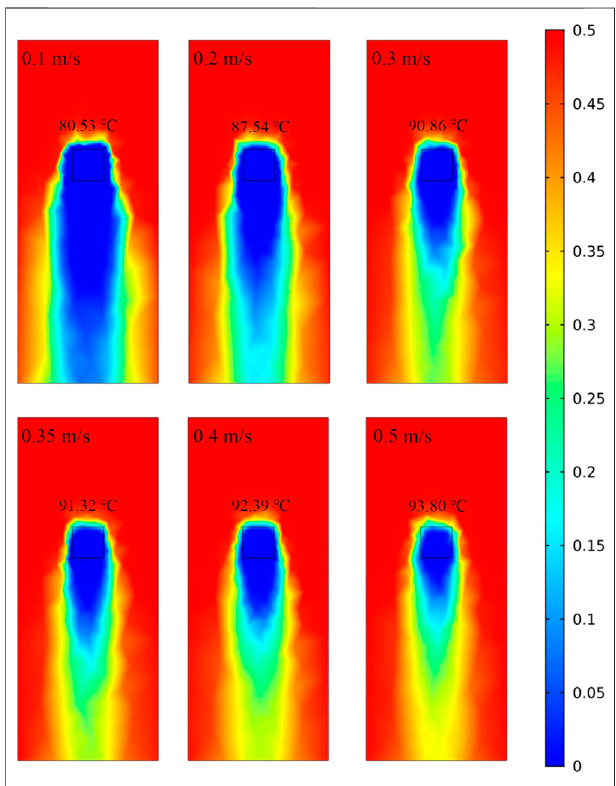
FIGURE12| Theeffectofthechangeinthesteam fl owrateonthephase change fi eld (the steam fl ow rate and the condensation surface temperature are given in the fi